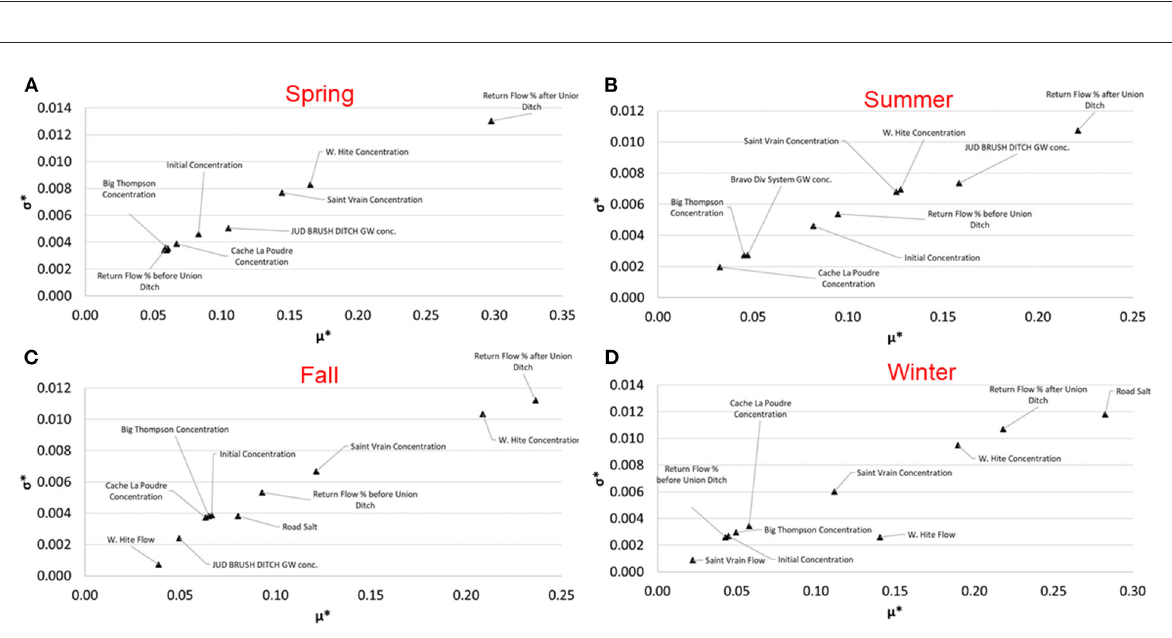
FIGURE10 Results for the temporal (seasonal) sensitivity analysis for (A) spring months (March–May), (B) summer months (June–August), (C) fall months (September–November), and (D) winter months (December–February), showing the interaction effects σ * plotted against the sensitivity index µ * for salt model